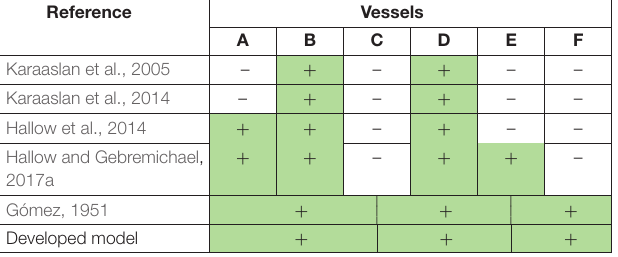
TABLE 1 | The RVR determination as the sum of the resistances of separate vessels: A, interlobar, arcuate, and interlobular arteries; B, afferent arterioles; C, glomerular capillaries; D, efferent arterioles; E, peritubular capillaries; F, interlobar, interlobular, and arcuate veins. Reference